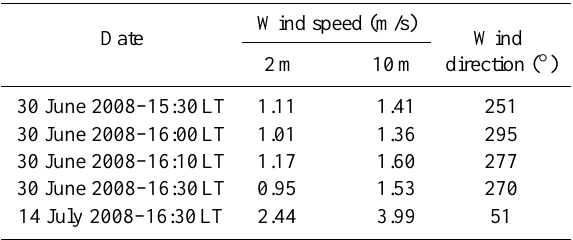
Table 1. Wind speed and direction measured at Yingke AWS for the selected neutrally stratified Planetary Boundary Layer conditions. The height of the top of the PBL was identified at 700m in each case.